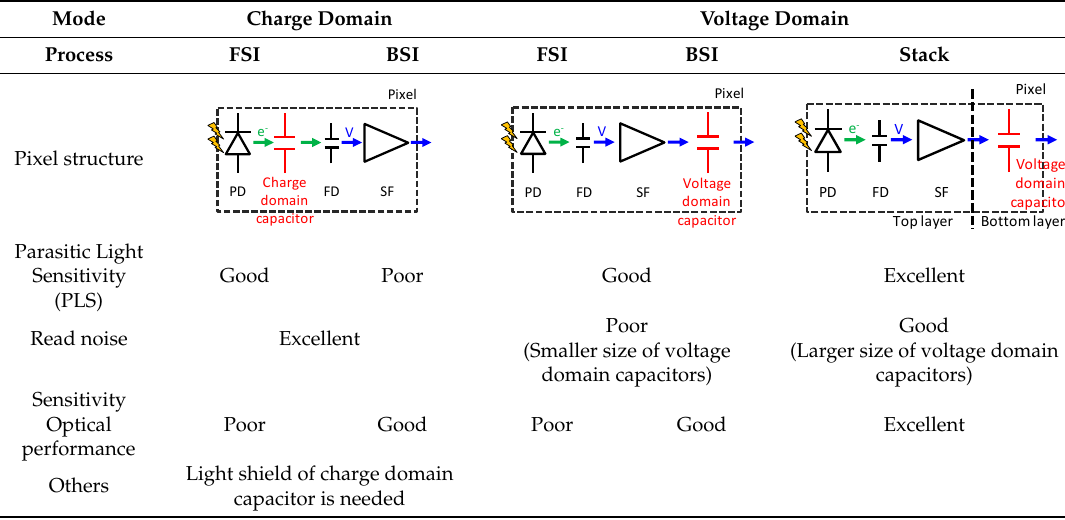
Table 1. Global shutter CMOS image sensors.